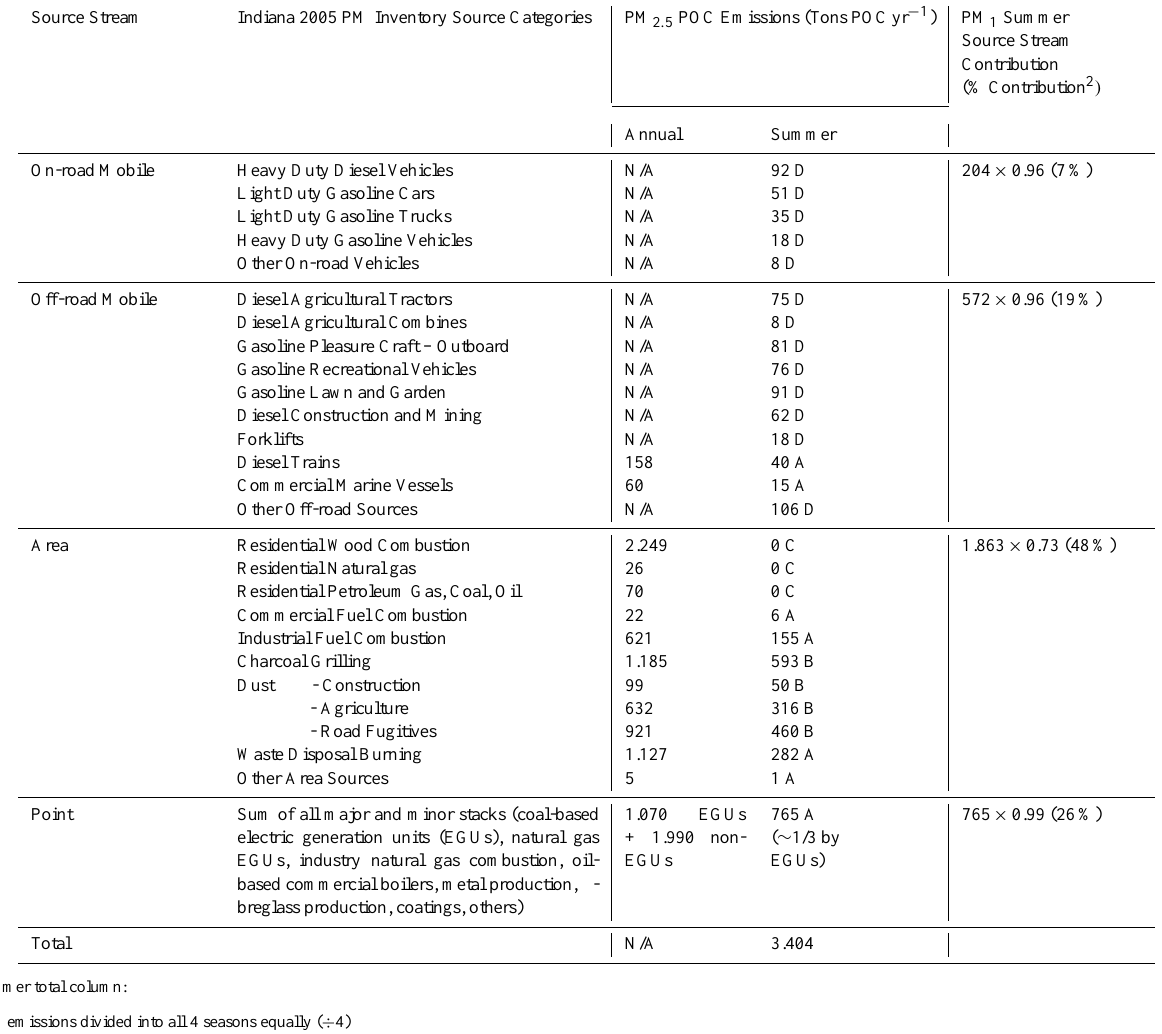
Table 2. POA inventory for the state of Indiana calculated with the 2005 US PM 2 . 5 emissions inventory with the application of SCC-specific PM chemical speciation profiles and sorted by importance into four aggregate source